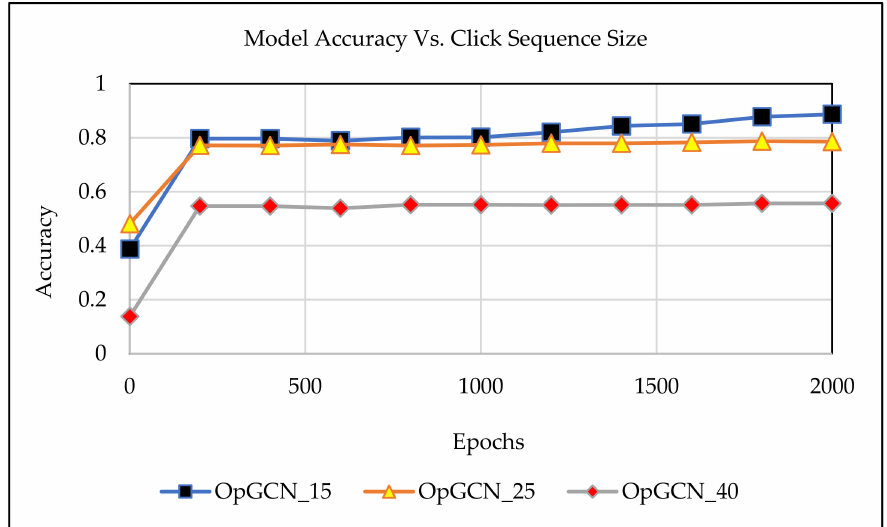
Figure 12. Length of click sequence Vs. Model (OpGCN)